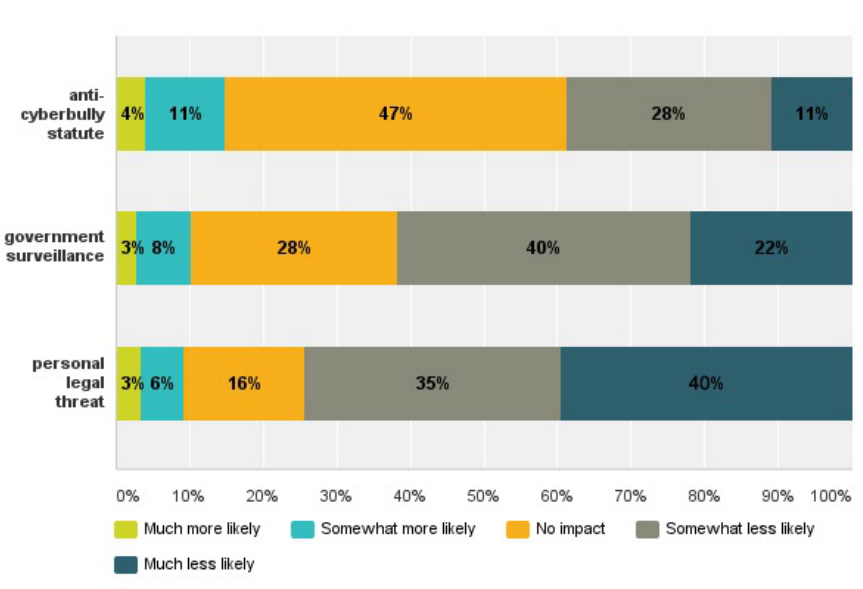
Figure 2: Impact on online speech II (carefulness about speech) Respondents were asked to indicate their level of agreement with the following statement,